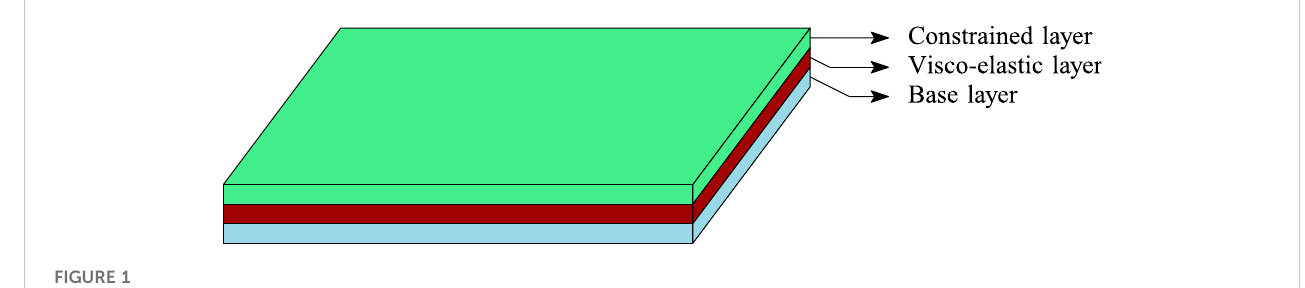
FIGURE 1 Plate structures with constrained-layer damping